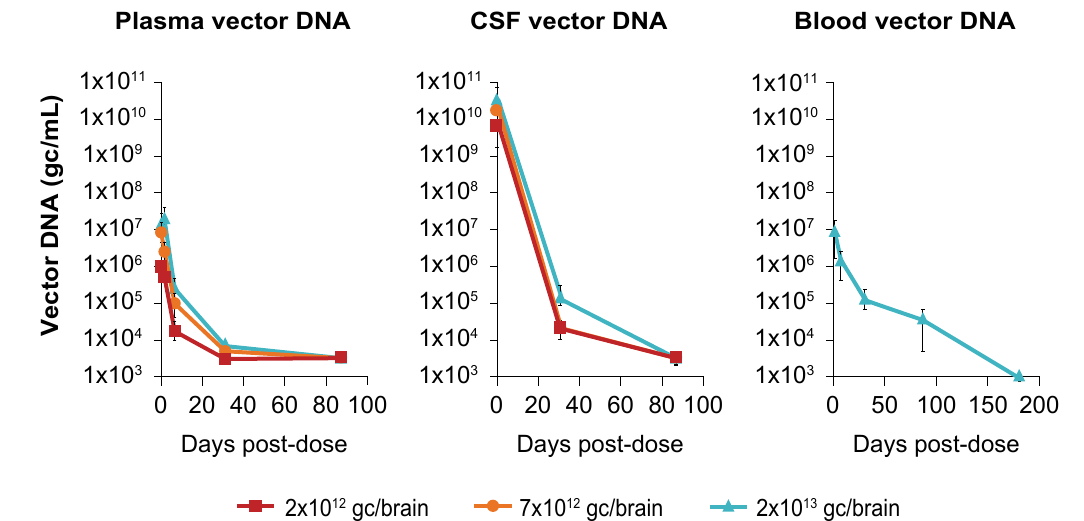
Figure 4. Shedding of vector DNA in body fluids in NHP after AAV5-miHTT injection. Vector DNA was found at high levels within 1 h after dosing in blood, plasma and cerebrospinal fluid (CSF), which declined over time until reaching levels close to the LLOQ (25 copies/reaction) by 3 (plasma and CSF) or 6 months (blood) after dosing. In feces, urine and semen vector DNA was found at day 7 and 1 months after dosing, but no vector was present after 3 months (data not shown). Vector DNA was present in saliva and nasal swabs at 3 months post dose, but not at 6 months (data not